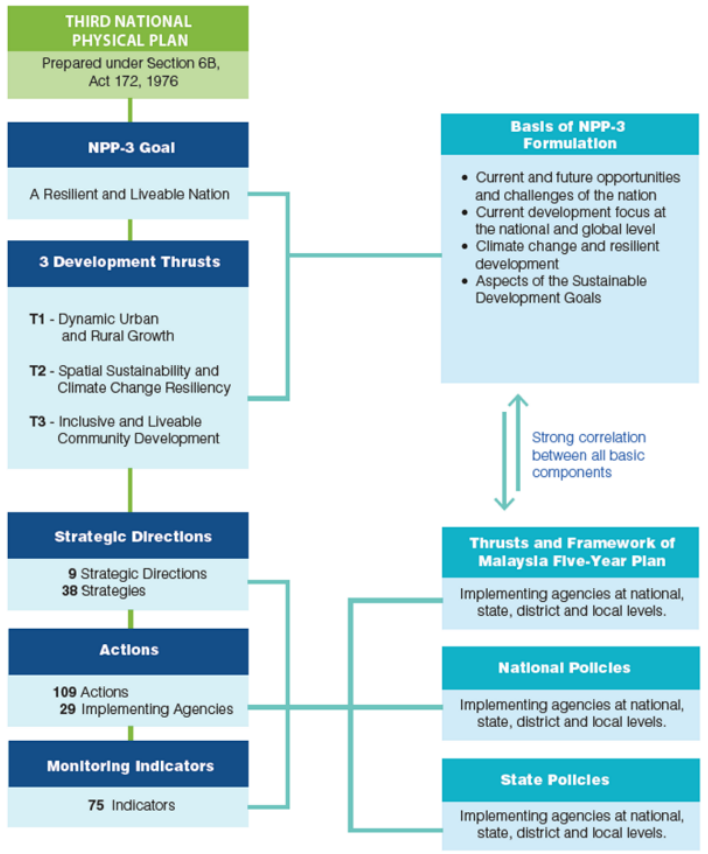
Figure 1. A framework of the 3rd National Physical Plan structure [14].